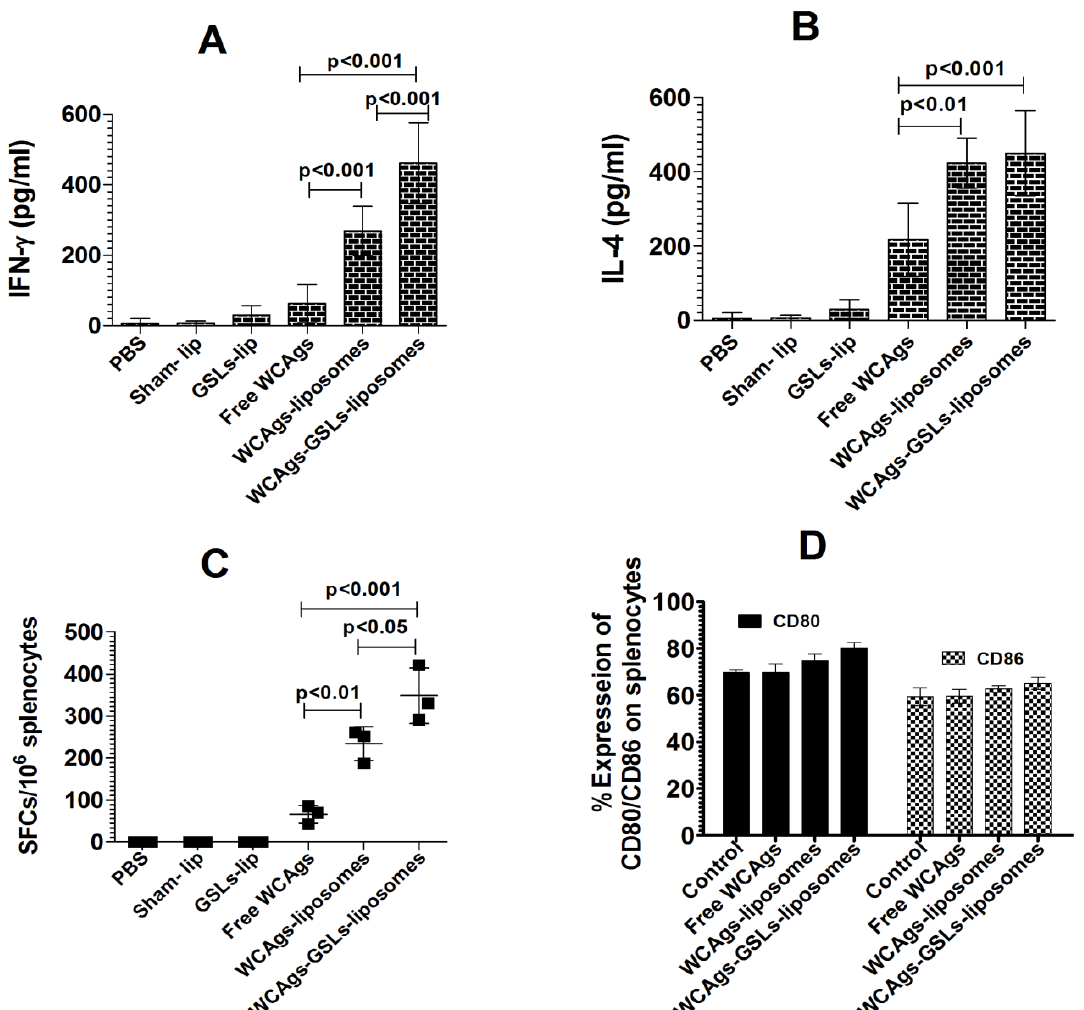
Figure 5. Immunization with WCAgs-GSLs-liposomes elicits greater immune responses. ( A ) IFN- γ, and ( B ) IL-4. The cells were exposed to WCAgs at a dose of 10 µg/mL. After 48 h, the amounts of IFN- γ and IL -4 were analyzed in the supernatant. ( C ) The frequency of IFN- γ producing splenocytes was determined by using an ELISPOT assay. ( D ) The splenocytes (5 × 10 5 ) from the mice of various immunized groups were treated with FITC-conjugated anti-CD11c and PE-conjugated anti- CD80/CD86 for 1 h. The cells were washed, fixed, and analyzed by flow cytometry. The data are representative of two independent experiments.